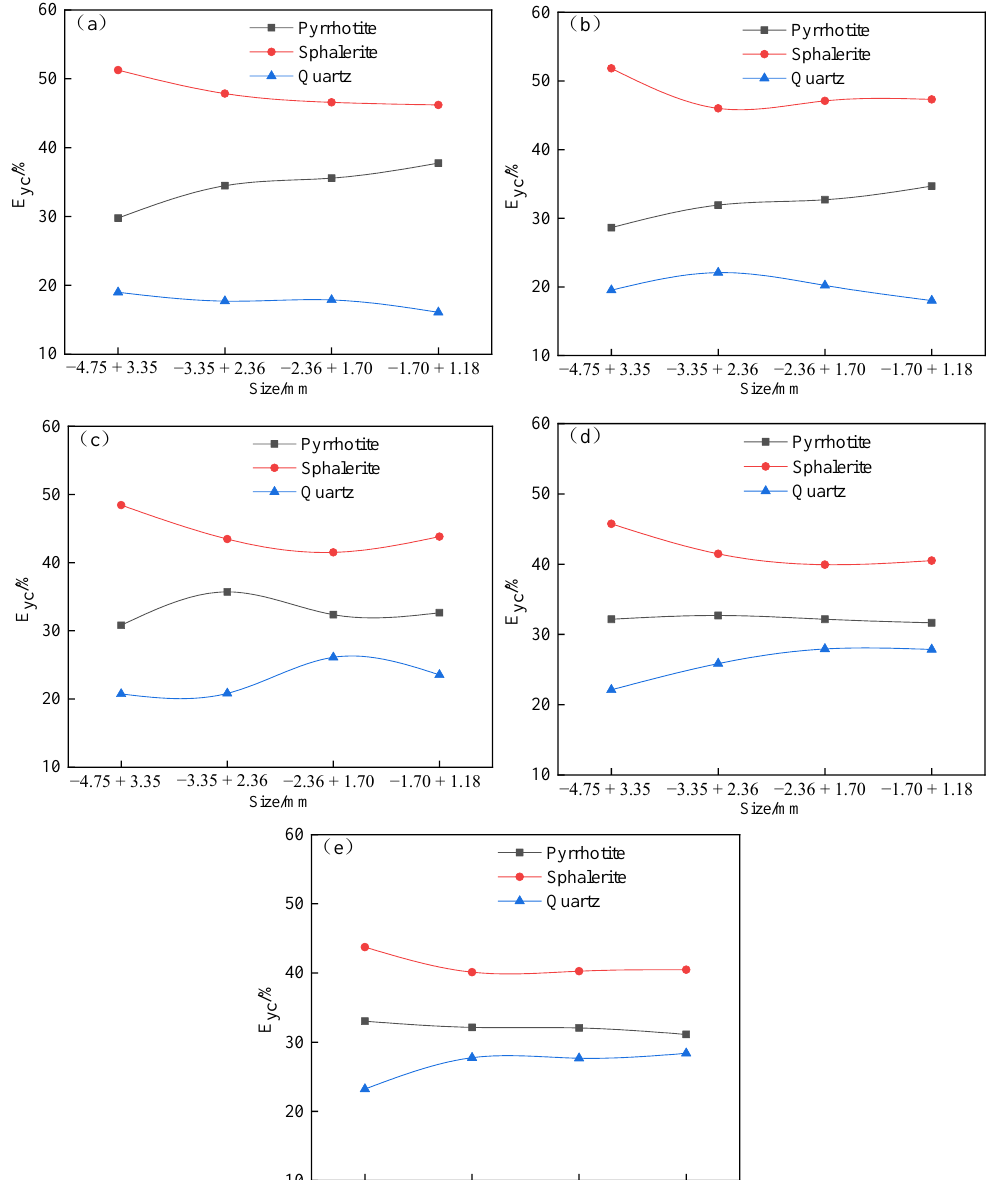
Figure 4. Contribution rate of component minerals with different grinding time to ore grinding characteristics (( a ): 1 min, ( b ): 2 min, ( c ): 4 min, ( d ): 6 min, ( e ): 8 min).